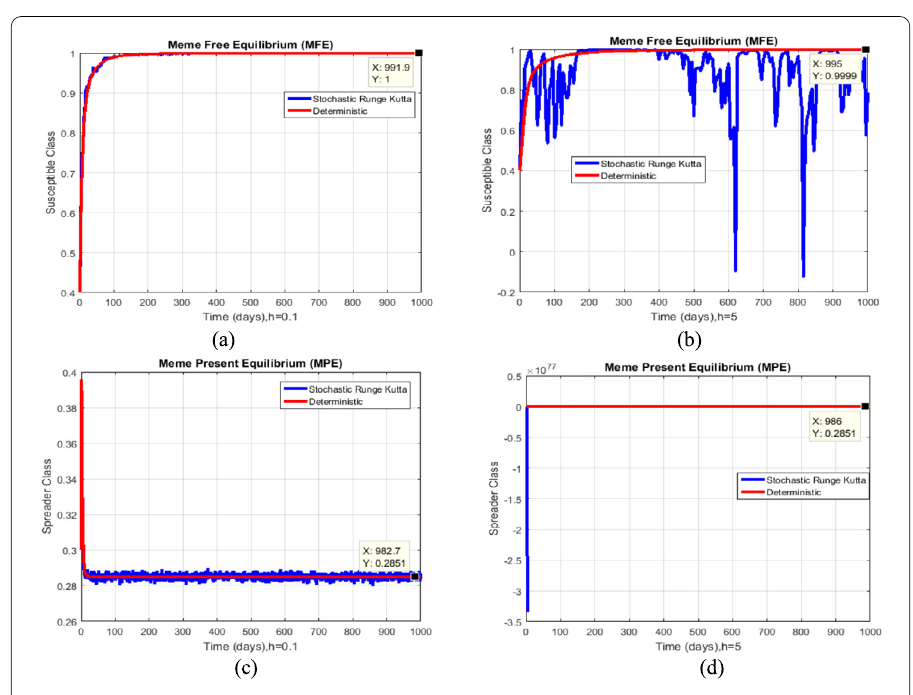
Figure 4 ( a ) Susceptible class for MFE at h = 0.1. ( b ) Susceptible class for MFE at h = 5. ( c ) Spreader class for MPE at h = 0.1. ( d ) Spreader class for MPE at h = 5